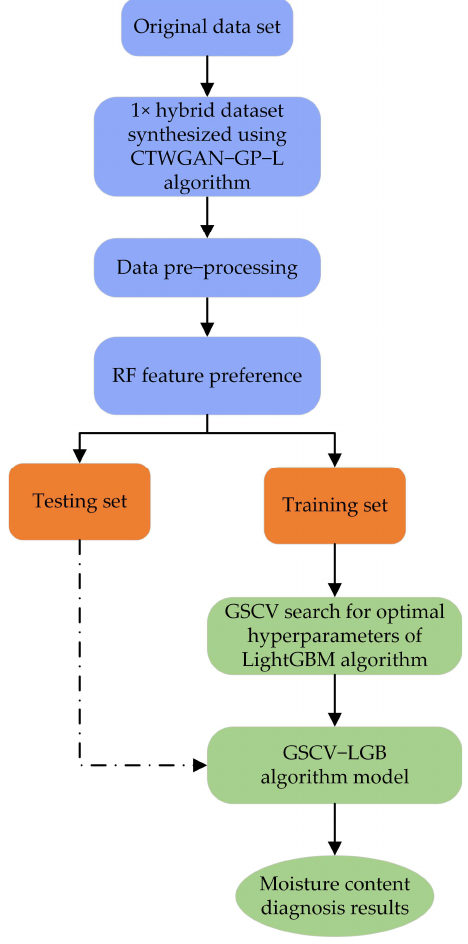
Figure 19. GSCV-LGB program workflow diagram.